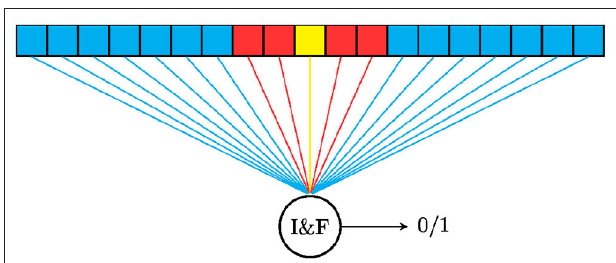
FIGURE 5 | Diagram of the spiking CFAR approaches for one cell. The cell under test is shown in yellow, the red cells are guard cells and have no influence on the result, and the blue cells are the neighbor elements, also called training cells. The weights are set differently for the spiking OS-CFAR and spiking CA-CFAR. Figure redrawn from López-Randulfe et al.